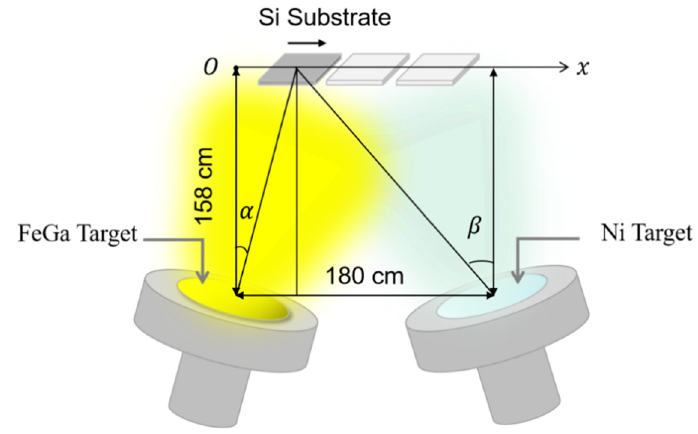
Figure 1. The schematic diagram of co-sputtering with different oblique sputtering angles. Table 1. The position and corresponding angles α and β .